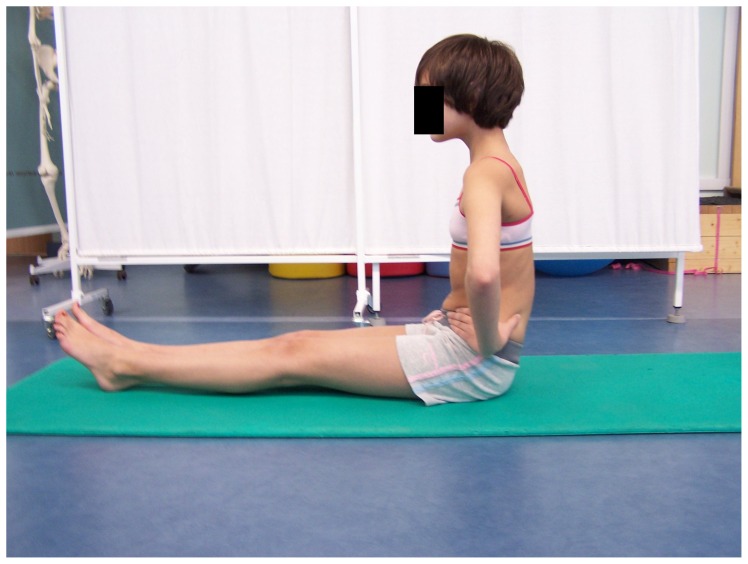
Static stretching of hamstrings.